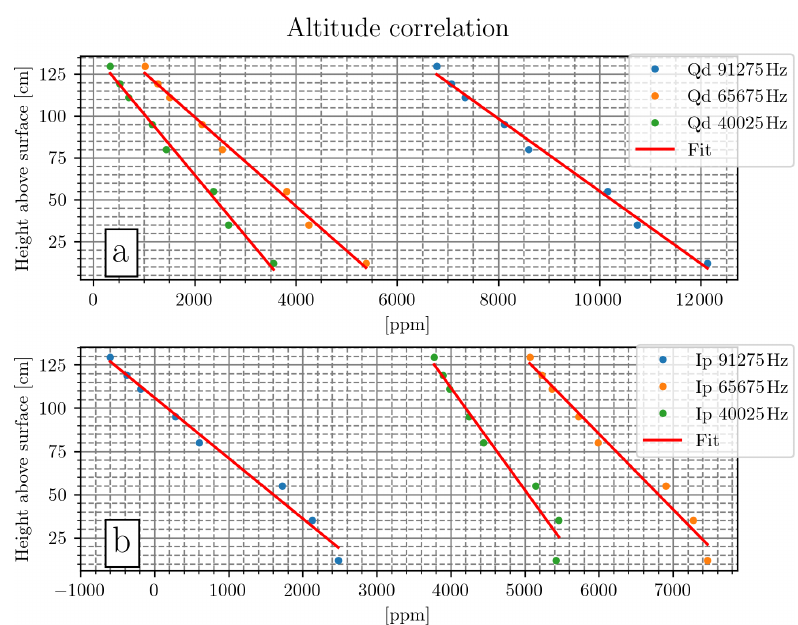
Figure 5. Results of Test 3 (measured parts-per-million values versus instrument altitude). Each measurement is a mean value of 3min at each altitude. The Pearson correlation coefficient between altitude and parts-per-million values is in the range [ − 0.98, − 0.99].